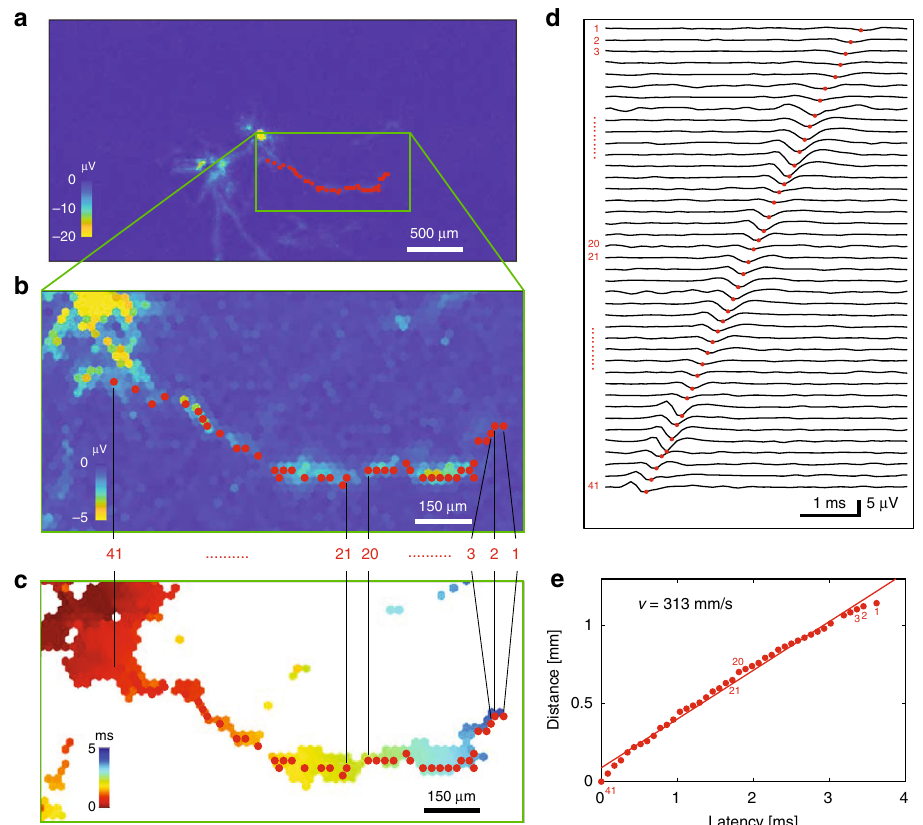
Fig. 4 Extraction of axonal segments. a Footprint of one neuron (signal amplitude is color-coded) with selected axonal segment marked with red dots; b zoom-in view of the selected axonal segment (signal amplitude); c delay map of the electrodes in the close-up view in b ; d waveforms from the selected electrodes in b and c ; and e linear fi t of distance versus latency for the selected axonal segment in b – d . The extraction procedure started with the last frame N featuring the largest delay (marked with 1), and proceeded backwards in time along the axonal structure. The next point was chosen by selecting the electrodes featuring a spike in the frame N − 1 within a radius of 80 µ m from the preceding point. If there were multiple electrodes within the same frame (e.g., between electrode numbers 20 and 21), the electrode with the largest amplitude was chosen. If there was no valid electrode within the frame N − 1, electrodes within the frame N − 2 were chosen according to the same procedure. The extraction was stopped fi ve frames before reaching the signal initiation region and the corresponding fi rst frame (e.g., at point 41 in the fi gure) in order to avoid including the signals of the electrical-activity initiation site (typically the distal end of the axon initial segment (AIS)). The signals, generated by the AIS, are very large and visible on many electrodes, so that precise signal timings are dif fi cult to assess in that